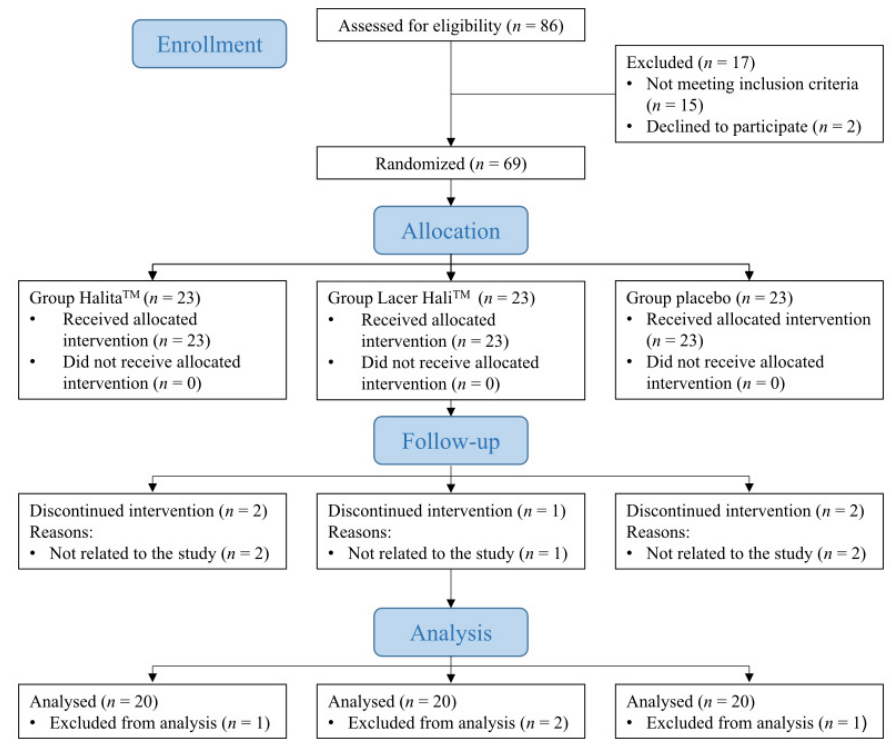
Figure 1. CONSORT flow chart of the study patients. 3.1. Analysis of the Organoleptic Test During the study, the most intense oral malodor was found in the placebo group. The average value for the Lacer Hali TM group was always higher than that of the positive control group, (Halita TM , Figure 2). The mean values and percentage variation of organoleptic scores are represented in Tables 1 and 2, respectively.